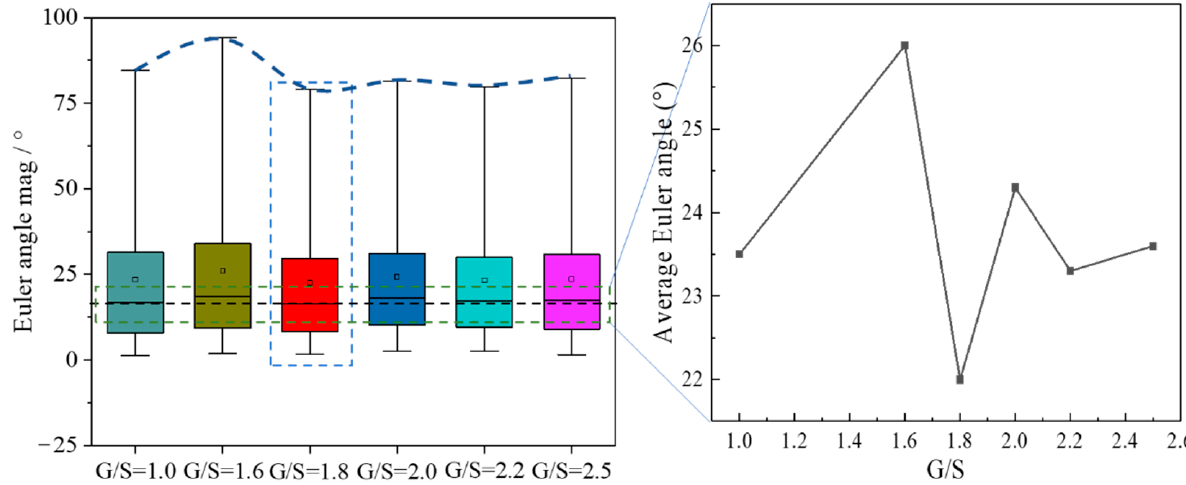
Figure 17. The variation of average Euler angles of particles with G/S level.